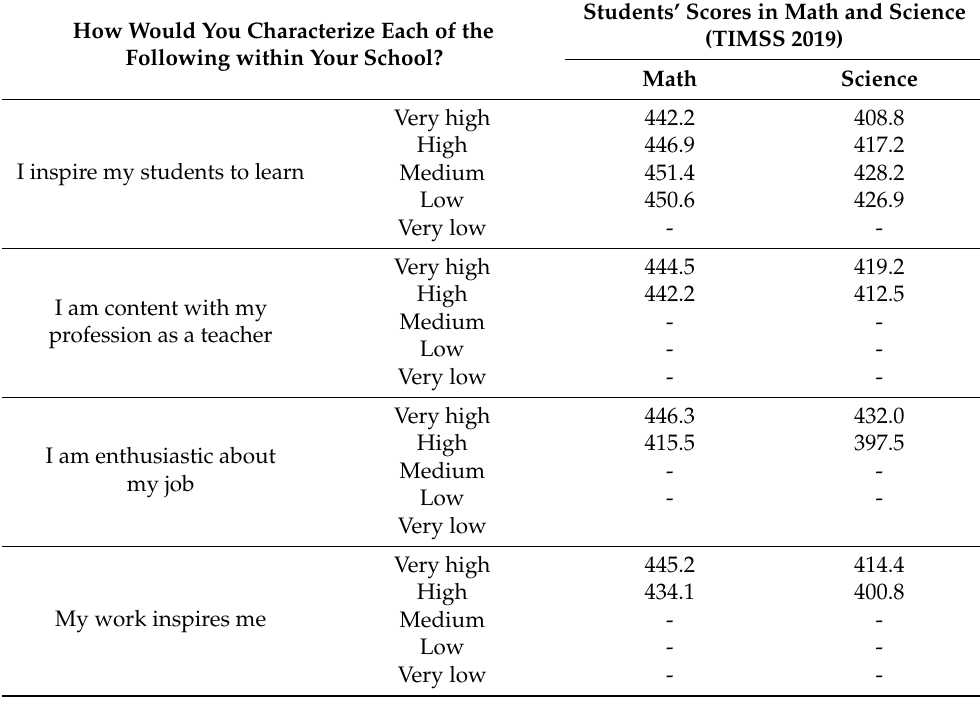
Table 4. TIMSS 2019 scores according to teacher